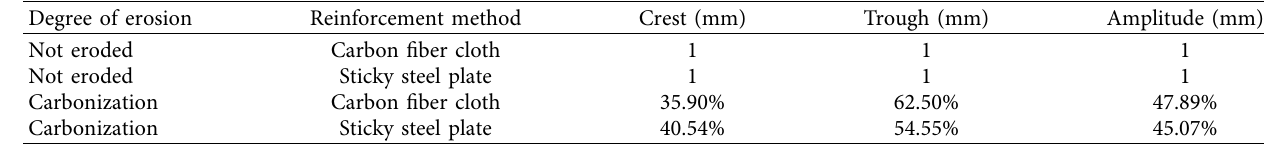
Table 16: Dynamic displacement growth rate of test plates under 2 million fatigue load cycles.